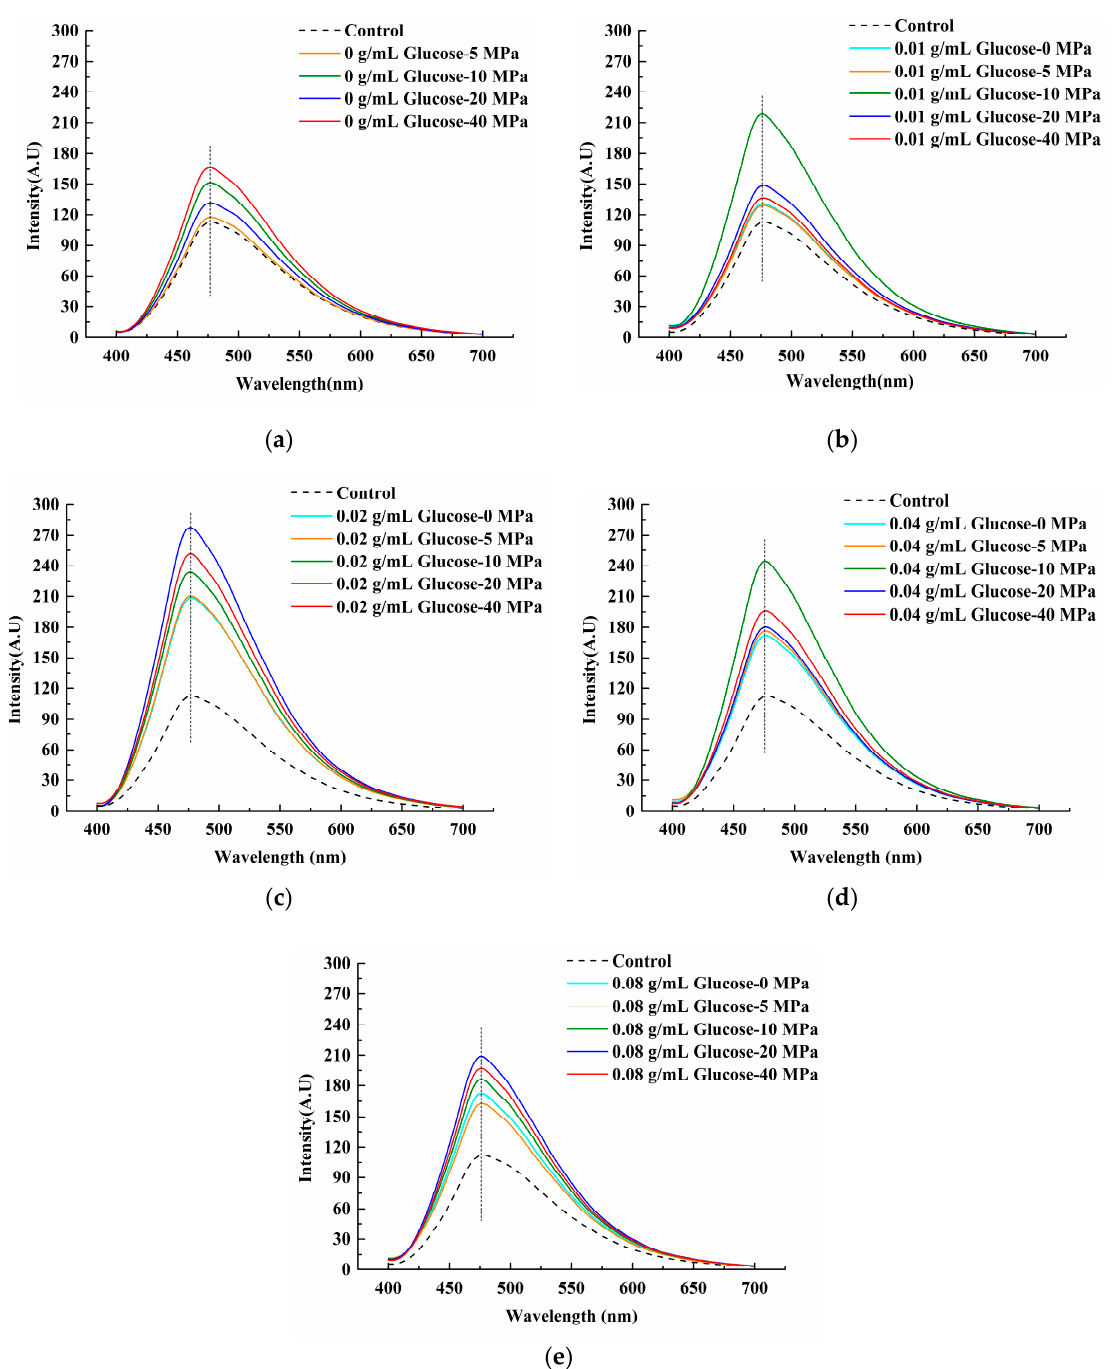
Figure 2. The exogenous fluorescence spectra of LWE under different homogenization pressure treatment and glucose concentrations. ( a – e ) Presented the exogenous fluorescence spectra of the LWE after adding 0 g/mL, 0.01 g/mL, 0.02 g/mL, 0.04 g/mL, and 0.08 g/mL glucose in turn.